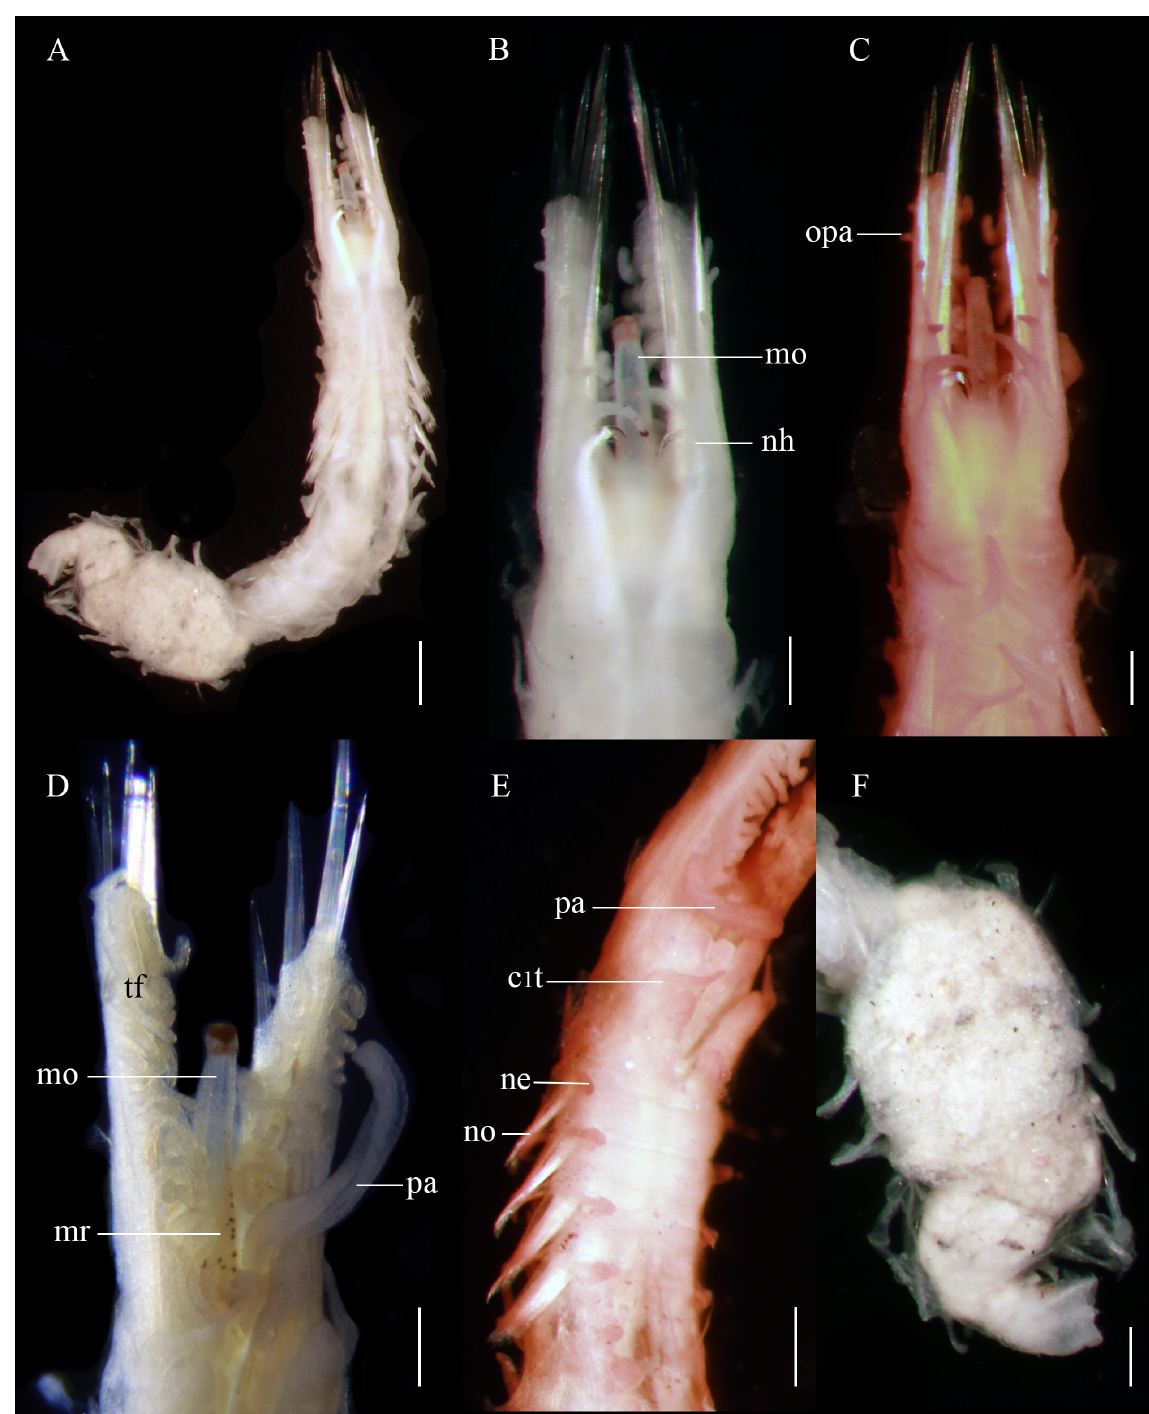
Fig. 1. Lygdamis pechi sp. nov., holotype (ECOSUR-302). A . Complete specimen, dorsal view. B–C . Anterior region, dorsal view. D . Median ridge and median organ, ventral view. E . Thorax and parathoracic region, ventral view. F . Posterior region, dorsal view. Abbreviations: c1t = cirrus 1 st thoracic segment; mo = median organ; mr = median ridge; ne = parathoracic neuropodium; nh = nuchal hooks; no = parathoracic notopod; opa = opercular papillae; pa = palps; tf = tentacular filament. Scale bars: A = 0.5 mm; B–F = 200